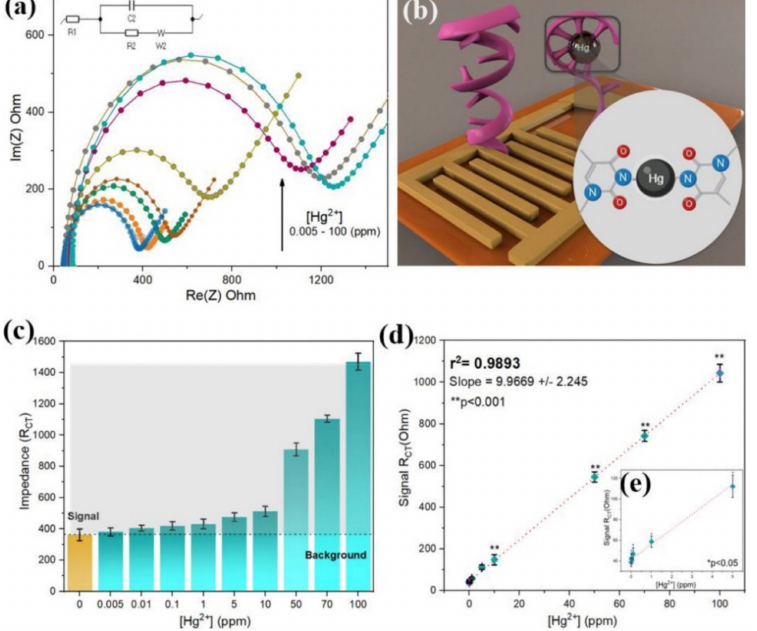
Figure 6. Inkjet − printed electrochemical apt sensor performance analysis; ( a ) Analytical Faradaic impedance response under optimal fabrication conditions; ( b ) Working electrode diagram; ( c ) The bar chart represents the overall reaction, and the shaded area represents the signal strength after subtracting the background; ( d ) Linear correlation between signal and target concentration; and ( e ) All the results correspond to the mean value from 5 independent replicates and the error bars represent 1 SD from the mean. Reprinted with permission from ref. [79]. Copyright 2019